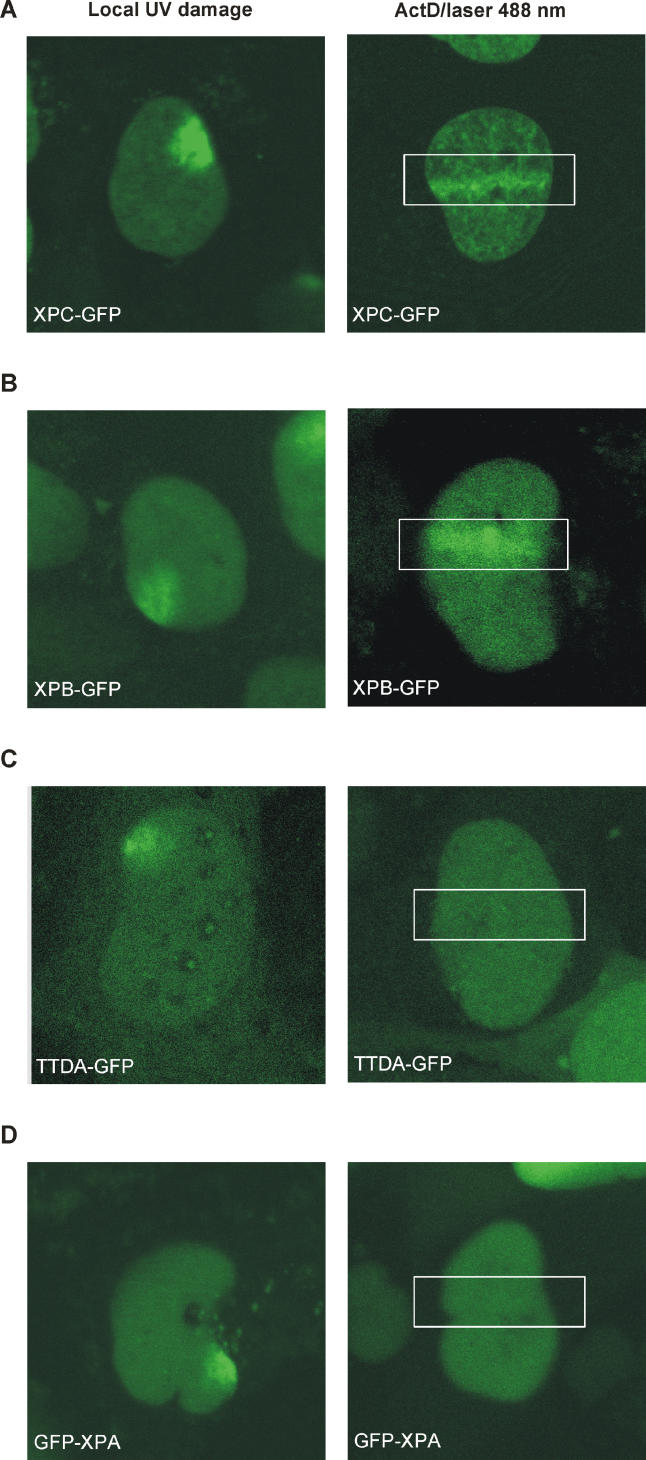
Comparison of Accumulation of NER Proteins on Local UV Damage and on Localized ActD-Photosensitized Laser Damage(A–D) Left panel, local DNA damage infliction by UV-C irradiation through a micro-porous filter. Right panel, local laser-induced (488 nm) DNA lesions by photo-sensitization of ActD.(A) XPC-GFP-expressing cells showing accumulation at local UV-damaged area (left panel) and laser induced ActD-damaged area (right panel).(B) XPB-GFP expressing cells showing accumulation at local UV-damaged area (left panel) and laser induced ActD-damaged area (right panel).(C) TTDA-GFP expressing cells showing only accumulation on local UV-damaged area (left panel) but not on laser induced ActD-damaged area (right panel); drawn rectangle corresponds with the irradiated area.(D) GFP-XPA expressing cells showing only accumulation on local UV-damaged area (left panel) but not on laser induced ActD-damaged area (right panel); drawn rectangle corresponds with the irradiated area.